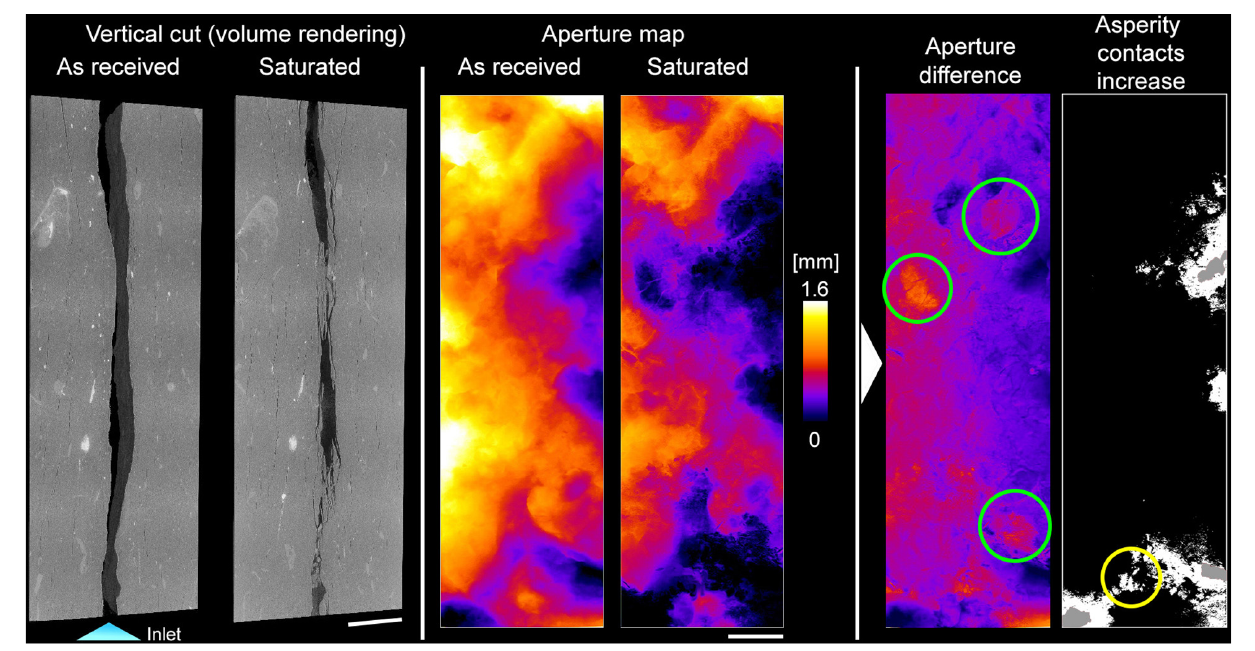
FIGURE 7 | Role of the hydration in the morphology of the fracture: volume renderings (left), and aperture maps (center) of the sample before and after hydration are shown. On the right, the difference in apertures and the evolution of asperity contacts is shown. In gray the starting contact areas are shown, and in white the new contact areas after saturation have been displayed. Areas of special interest have been highlighted: the generation of choke points because of the swelling and fracturing of material close to the fracture surface (green circles), and the generation of the main choke point which will be responsible of the hydraulic sealing on this specific sample (yellow circle) during the differential pressure